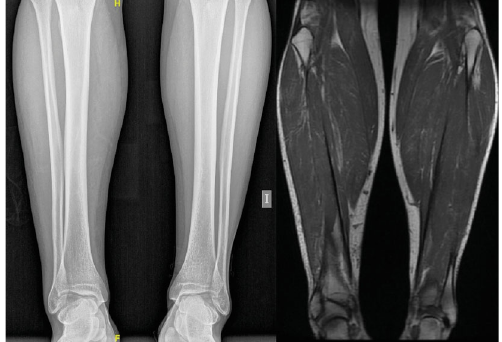
Figure 2: X-ray and MRI study did not show any bony or musculotendinous injury.